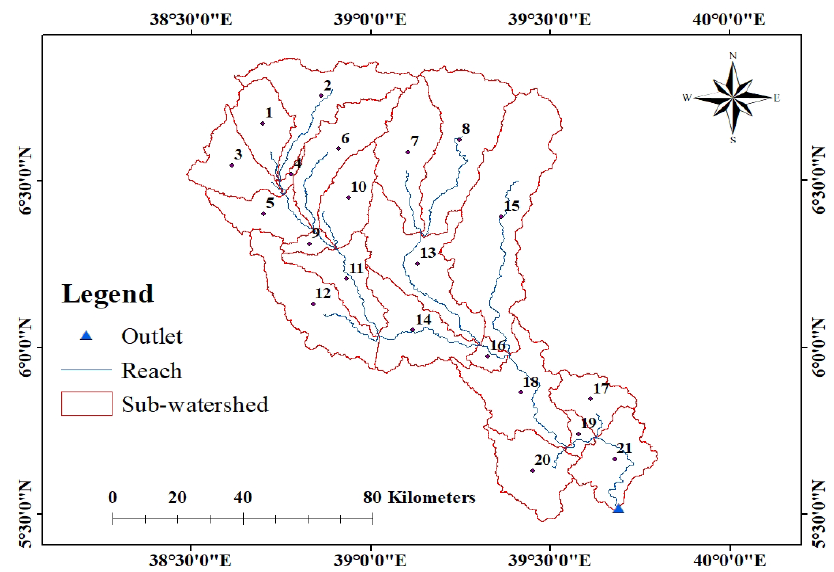
Figure 3. Sub-watershed of upper Genale River basin (The numbers 1 through 21 represented the number of sub-watersheds).